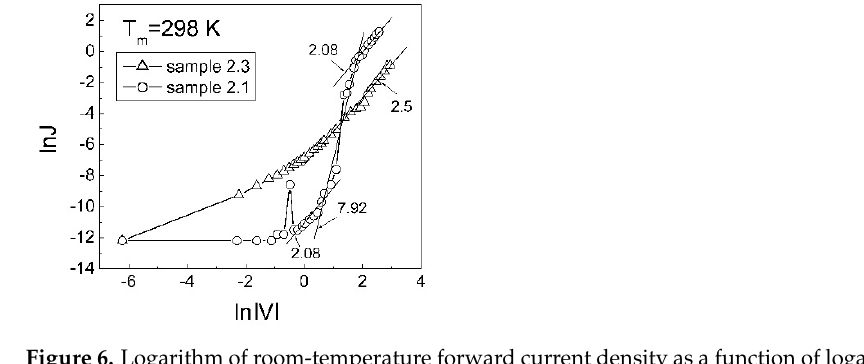
Figure 6. Logarithm of room-temperature forward current density as a function of logarithm absolute voltage for the MIS structures with ZnO:N films, deposited at Ar:O 2 :N 2 = 50:10:40 (sample 2.1) and after RTA at 550 °C (sample 2.3).